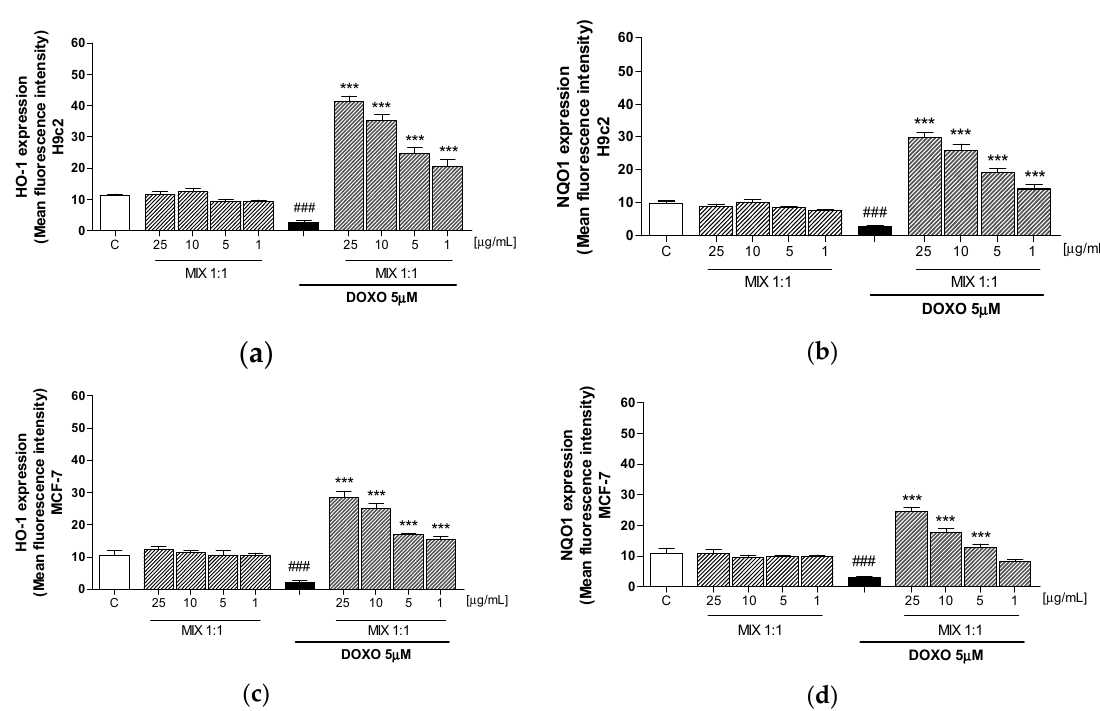
Figure 4. Effect of most effective smoothies’ MIX 1:1 ratio (1–25 μ g/mL), on HO-1 and NQO1 Figure 4. E ff ect of most e ff ective smoothies’ MIX 1:1 ratio (1–25 µ g / mL), on HO-1 and NQO1 expression, expression, alone and in combination with DOXO (5 μ M) in H9c2 ( a , b ) and MCF-7 ( c , d ) cells, alone and in combination with DOXO (5 µ M) in H9c2 ( a , b ) and MCF-7 ( c , d ) cells, evaluated by cytofluorimetric technique. Data are expressed as mean ± s.e.m. of mean fluorescence intensity. *** denotes p < 0.001 vs DOXO; ### denotes p < 0.001 vs C.